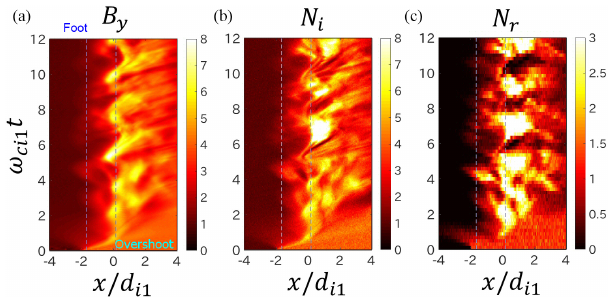
Figure 3. Temporal variation of the shock magnetic field B y and the ion density N i at the overshoot and in the foot region for Run A. The left panels show the result of the small-scale simulation run (at y/d i1 = 0). The right panels show the result of the large-scale simulation run (at y/d i1 = 3). The shock overshoot is defined as a position where the shock magnetic field averaged for the time in- terval of ω ci1 t = 4–12 is maximum. The shock foot is defined as a position 1 . 5 d i1 away upstream from the